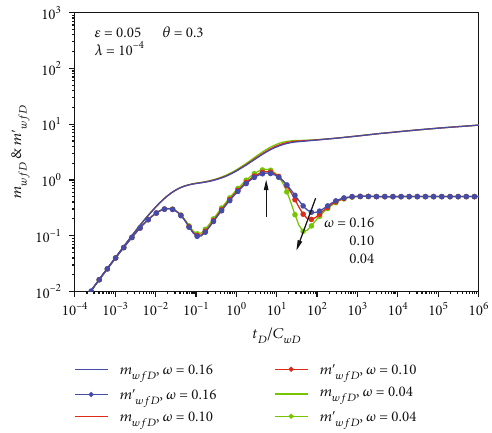
Figure 11: The in fl uence of pressure propagation coe ffi cient.